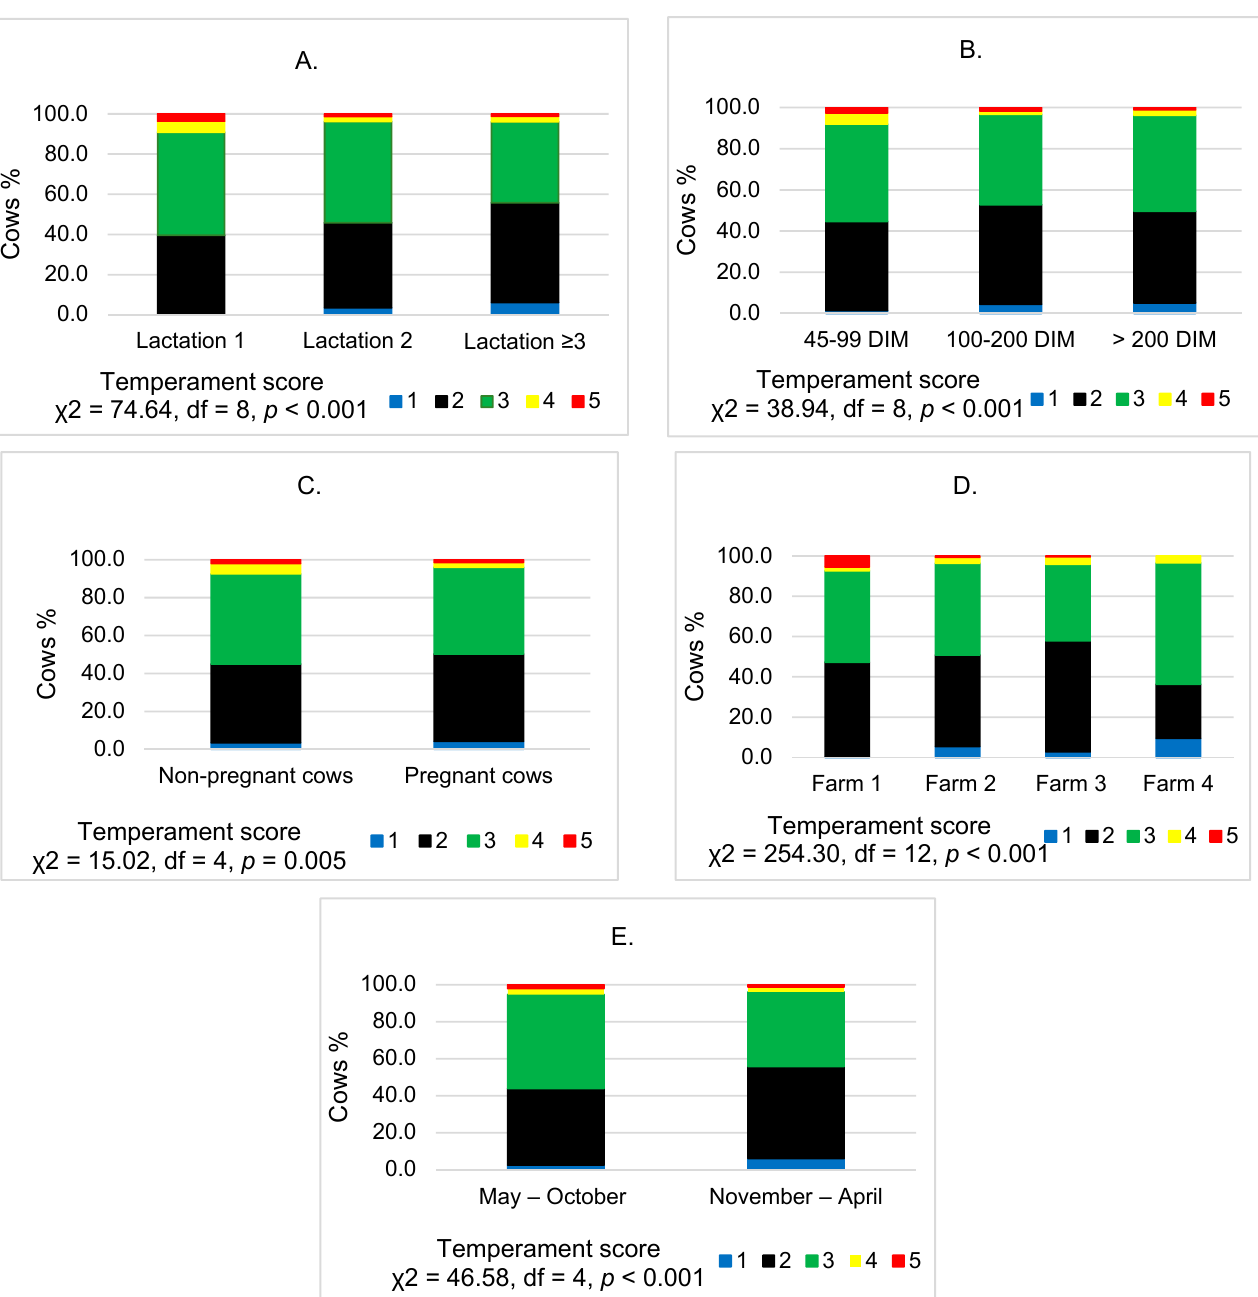
Figure 1. Cow temperament scores assessed by lactation, days in milk, reproductive status, farm and season. ( A ) Evaluation of cow temperament (scores) according to lactation; ( B ) Evaluation of cow temperament (scores) according to days in milk; ( C ) Evaluation of cow temperament (scores) according to reproductive status; ( D ) Evaluation of cow temperament (scores) according to farm; ( E ) Evaluation of cow temperament (scores) according to season. 1—very slow–very calm; 2—slow–calm; 3—normal; 4—sensitive–aggressive; 5—very sensitive–very